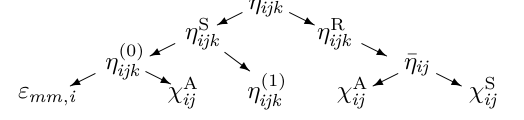
Figure 1. Scheme of decomposition